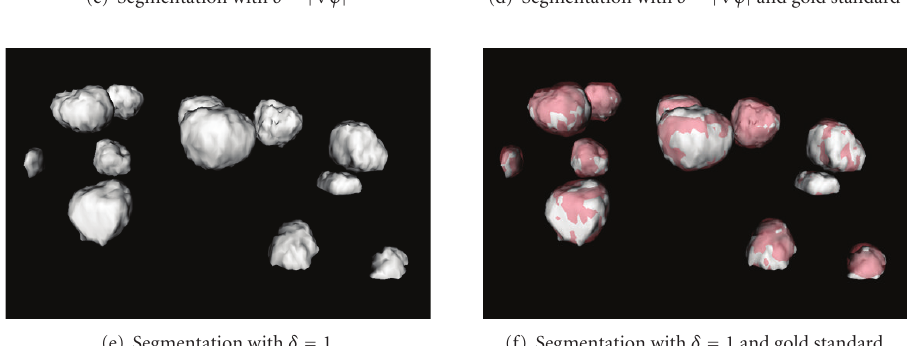
Figure 5: A region of interest selected on real data, gold standard obtained by manual segmentation, and surfaces segmented using (4) and (5). In every case μ = 0 . 05. Steady state is, respectively, after 1300 and 1500 iterations. (a) Isosurface of original data. (b) Gold standard. (c) Segmentation with δ = |∇ φ | . (d) Segmentation with δ = |∇ φ | superimposed to gold standard (red, transparent). (c) Segmentation with δ = 1. (d) Segmentation with δ = 1 superimposed to gold standard (red, transparent). Using δ = |∇ φ | is not possible to segment all the nuclei in the